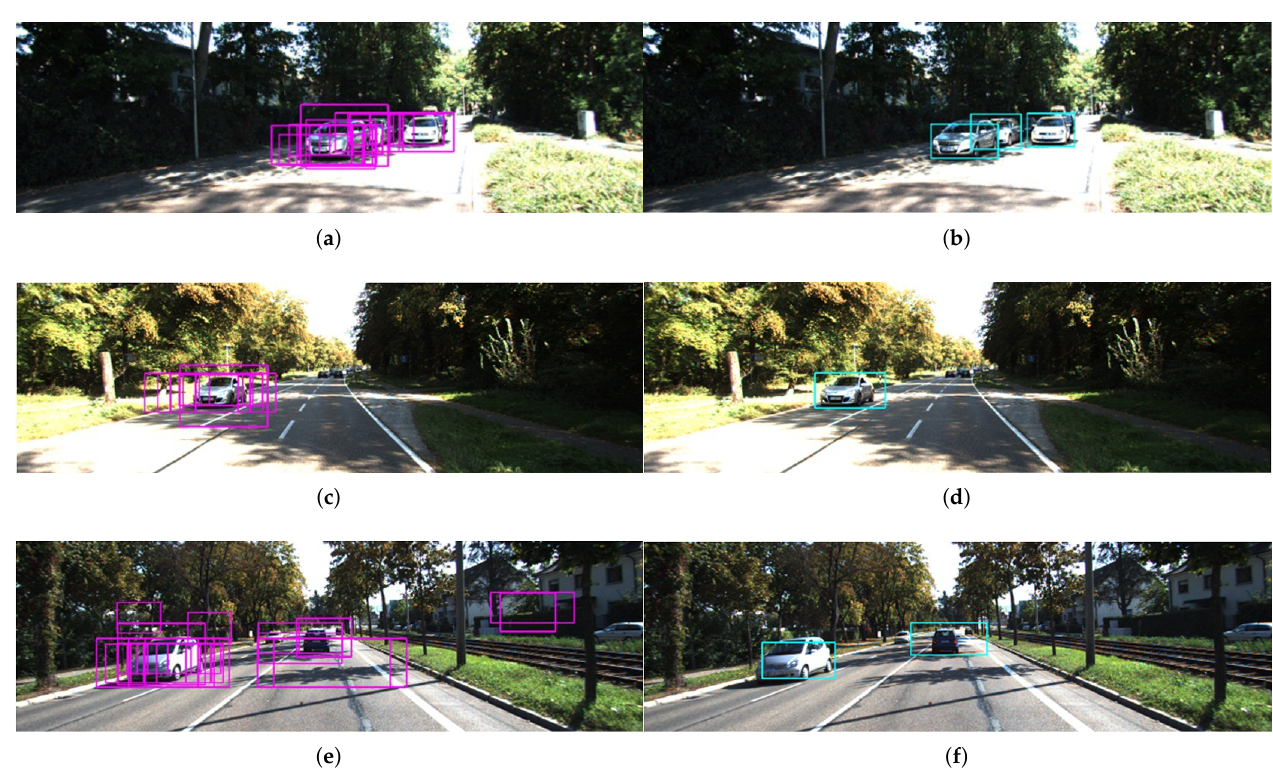
Figure 8. Illustration of the effect of mean-shift-based non-maximum suppression (NMS) on CESDD-based vehicle detection. Purple boxes are initial detections from window classification process; cyan boxes are refined detections through the adapted mean-shift-based NMS. ( a , c , e ) show initial detections; ( b , d , f ) show corresponding refined